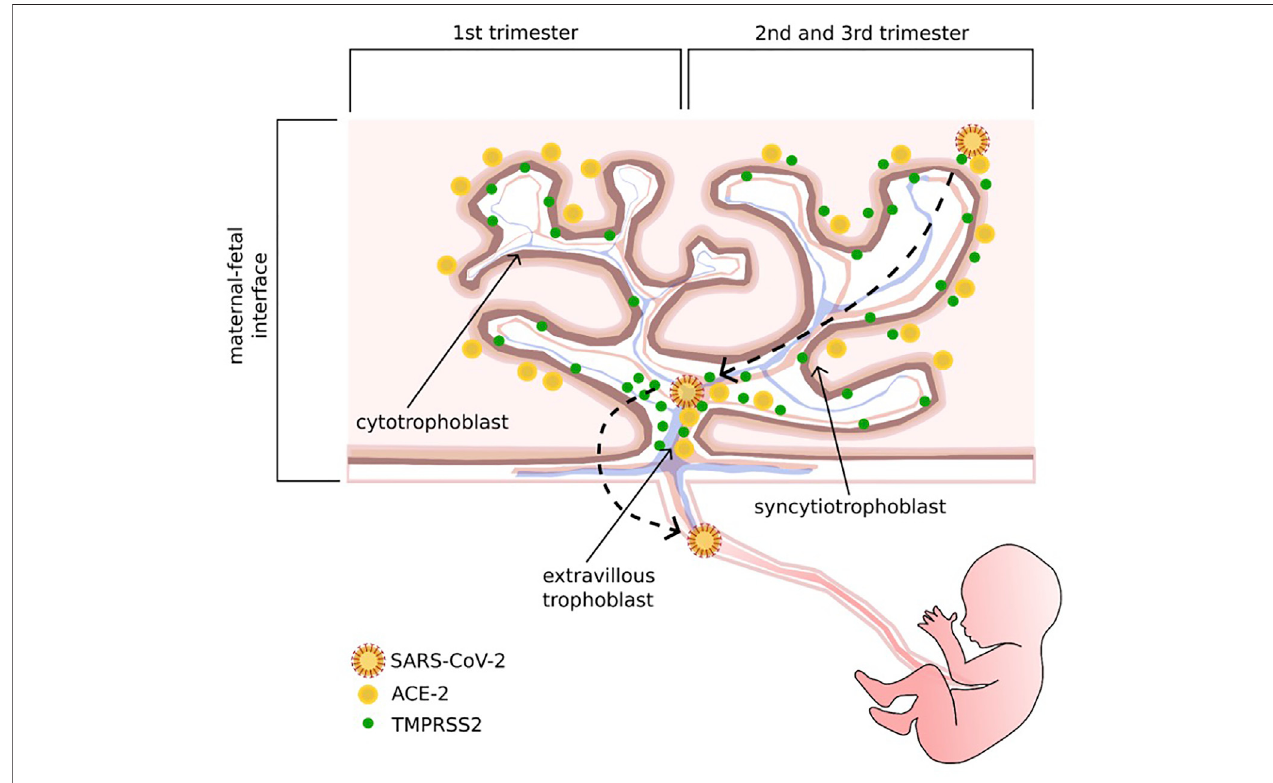
FIGURE1 | Schematic representation ofACE 2 and its co-receptor, TMPRSS 2, distribution through trimestersand trophoblastlayers, and the potentialadhesion and invasionpathwaysofSARS-CoV-2.Inthe fi rsttrimester,ACE2ispreferentiallyexpressed inthesyncytiotrophoblastlayer,whileTMPRSS2ismostlylocalizedonthe cytotrophoblast and extravillous trophoblast layers; in the second and third trimesters, ACE2 is also expressed on the extravillous trophoblast layer, and TMPRSS2 can be found on all trophoblast